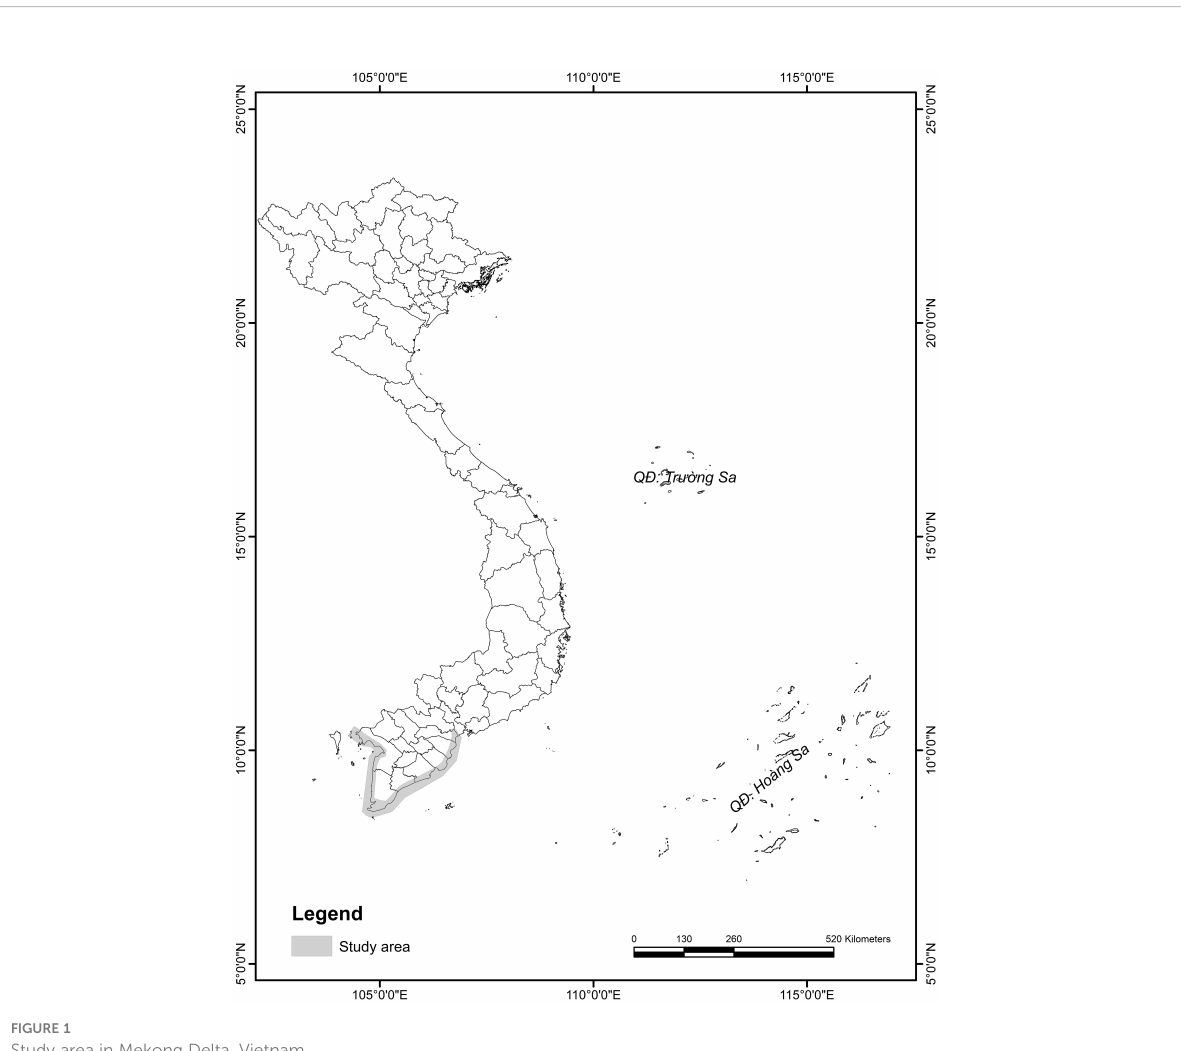
FIGURE 1 Study area in Mekong Delta,